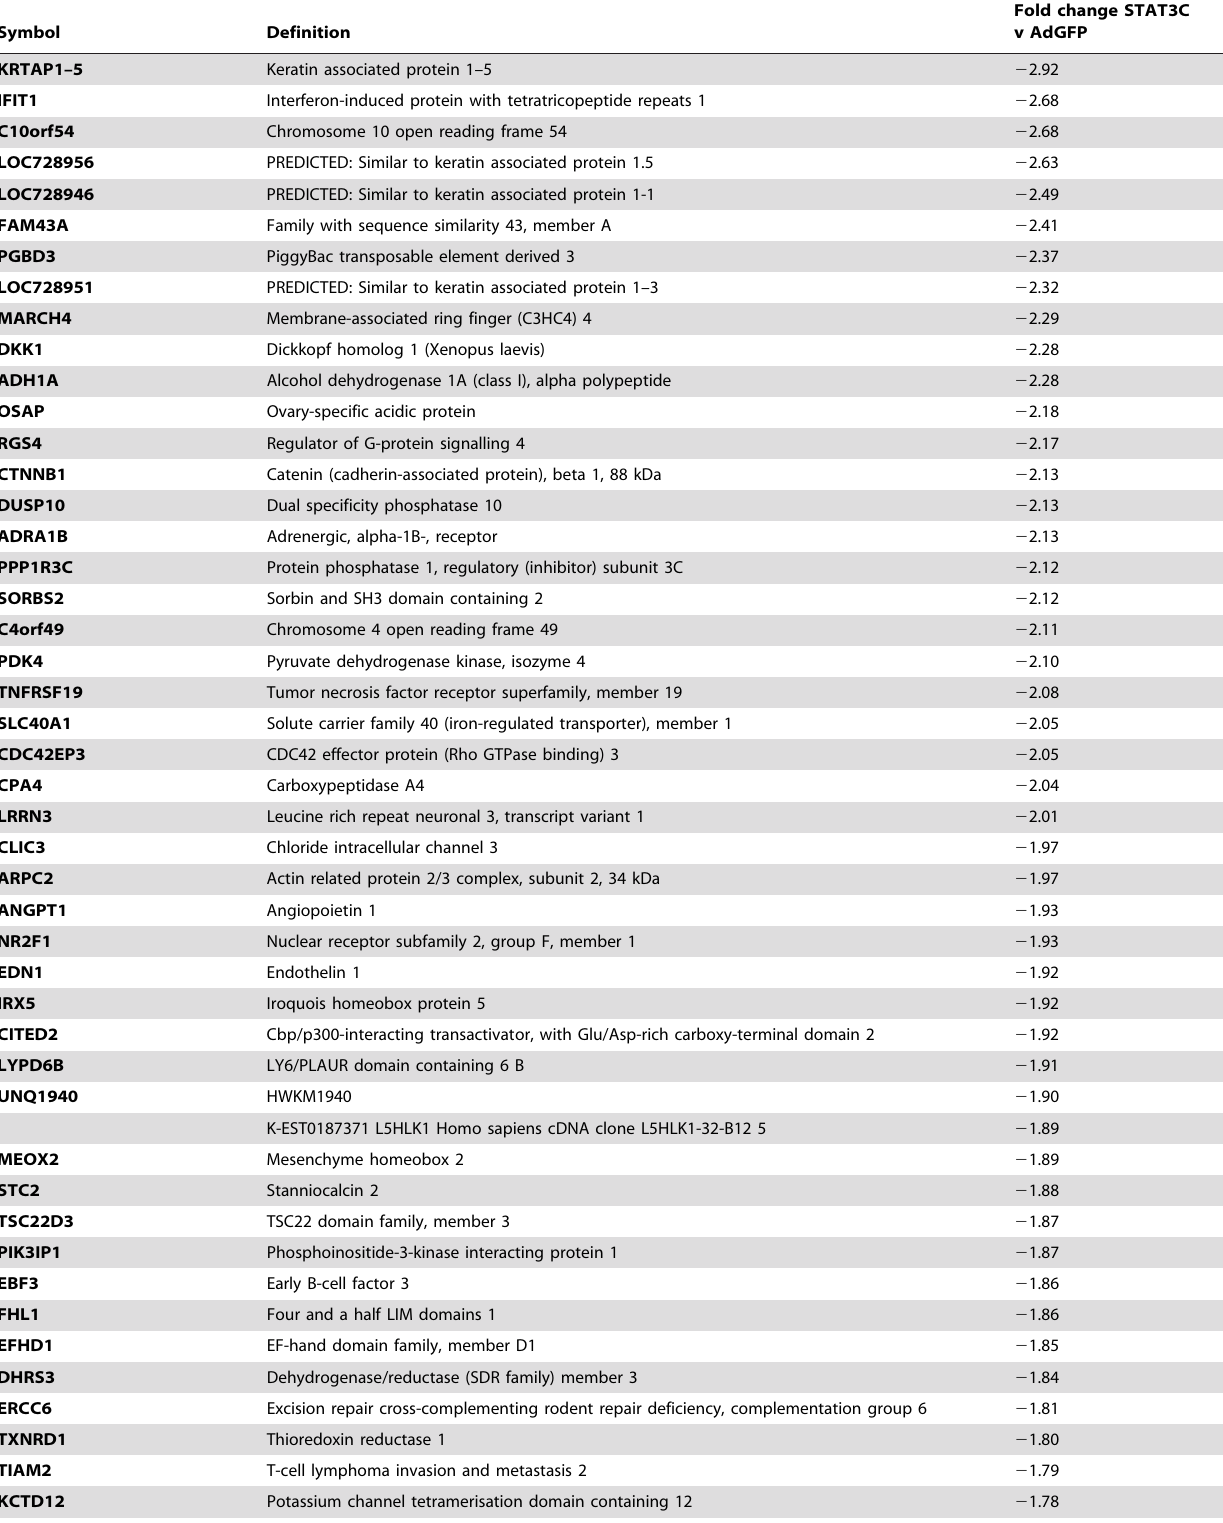
Table 2. Genes down-regulated by